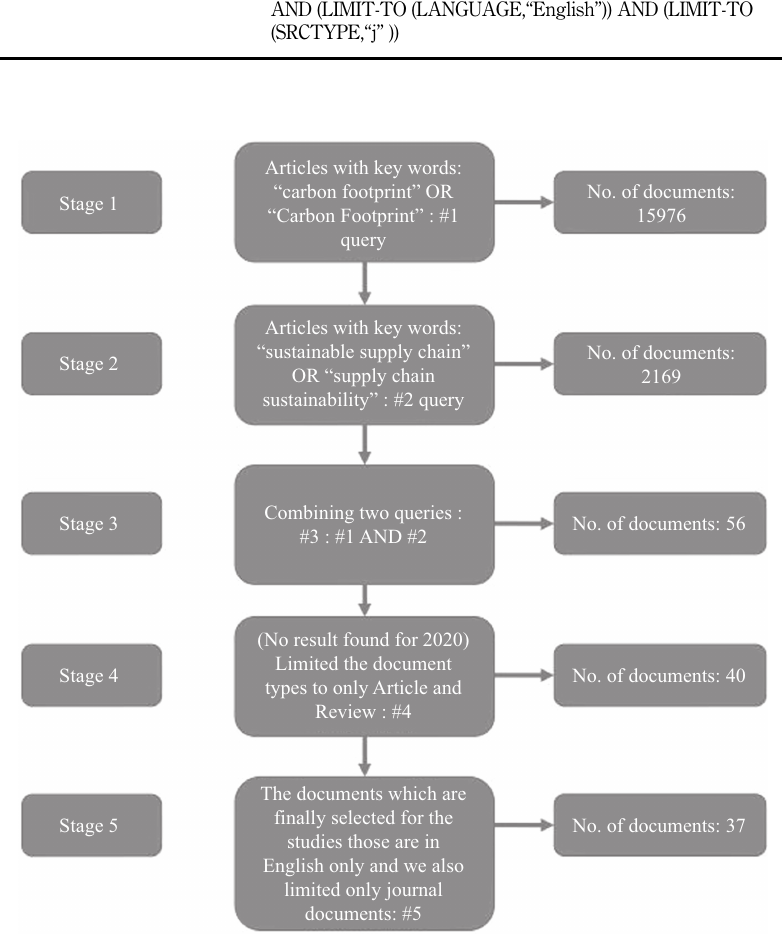
Table 2. Table for search syntax